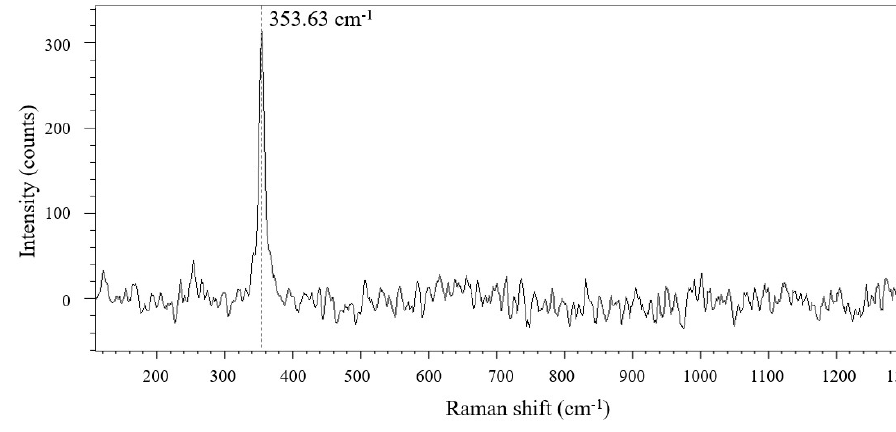
Figure 7. Typical Raman spectrum collected at locations with high portlandite